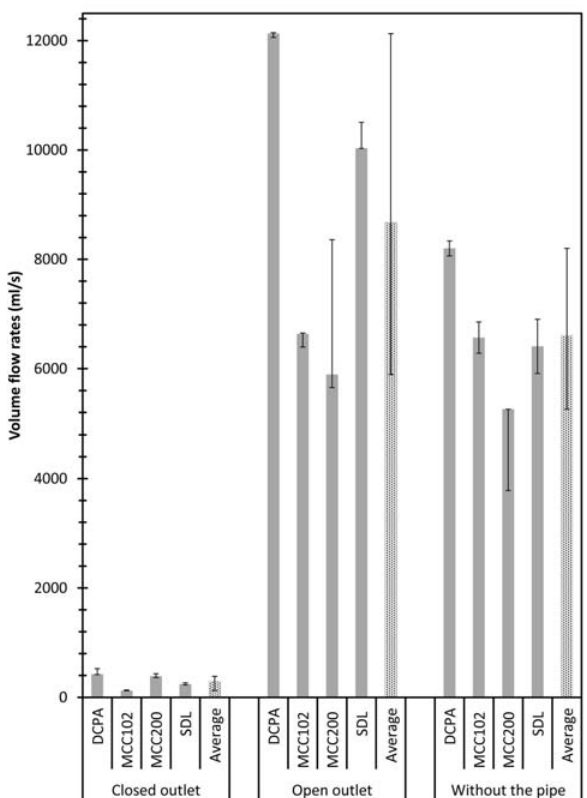
Figure 9. Volume flow rates in closed outlet, open outlet condi- tion, and the condition without the pipe as measured 700 mm be- low knife valve for all tested materials: dicalcium phosphate anhydrous (DCPA), microcrystalline cellulose MCC102 and MCC200, and spray-dried lactose (SDL). Bar plots present me- dian value, error bars indicate minimum and maximum values. For each condition average value of all tested materials is presen- ted (blue) with error bars indicating minimum and maximum va- lues.